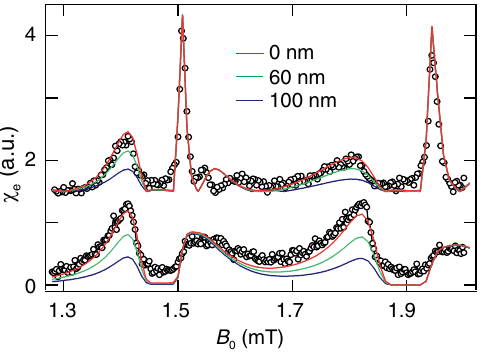
FIG. 9. Simulated spin spectrum (lines) for Res1 when incor- porating Schottky barriers of height 0 eV (0 nm), 0.3 eV (60 nm), and 0.7 eV (100 nm). Measured data (symbols) at two pulse amplitudes are the same as shown in Fig. 2(a).